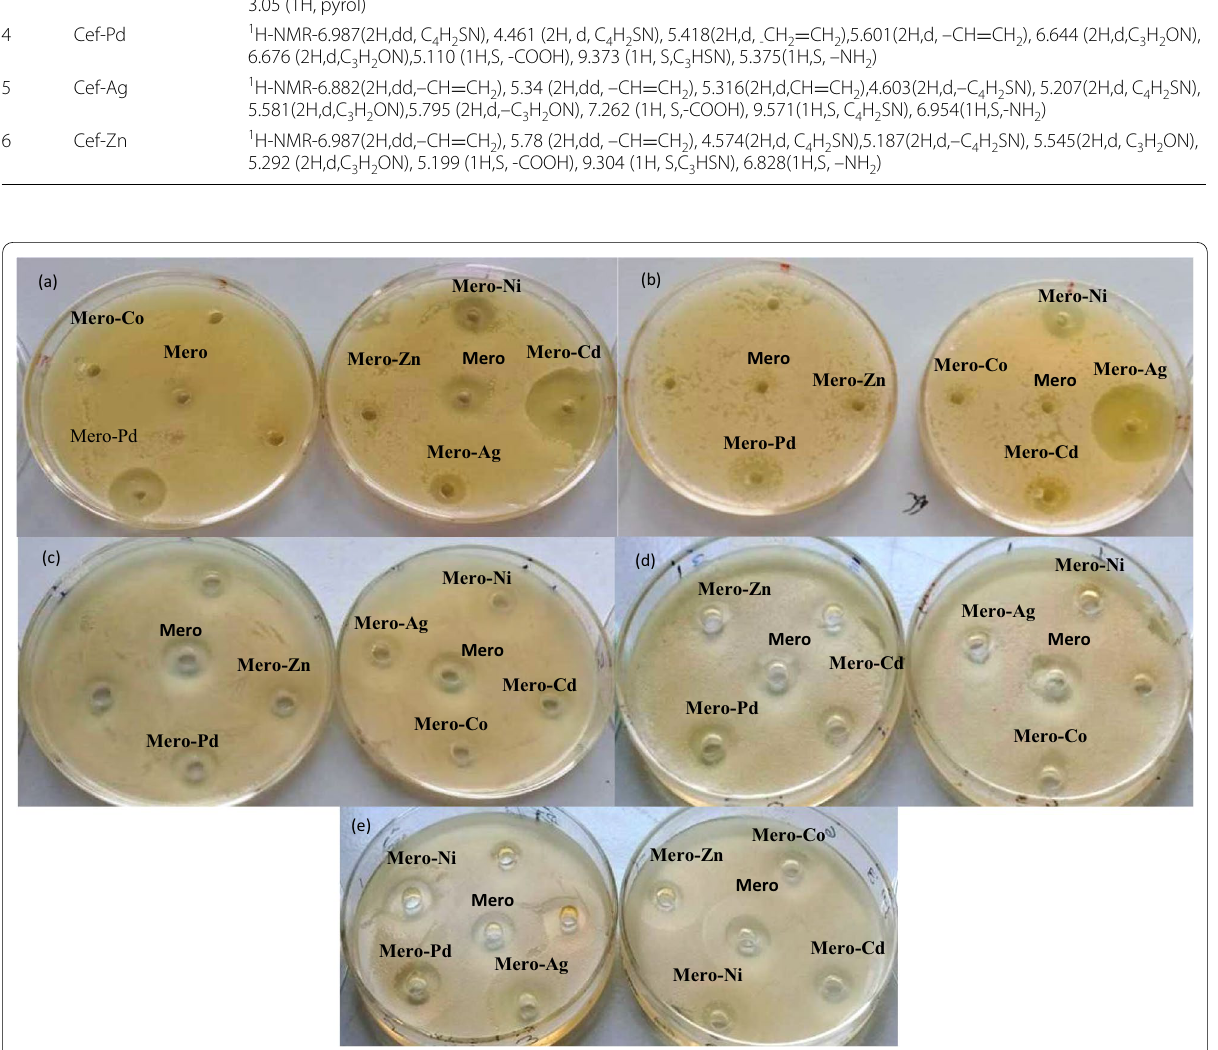
Fig. 6 Antibacterial activity by meropenem and its synthesized complexes against a P. aeruginosa , b K. pneumonia , c E. coli , d B. subtilis and e S.